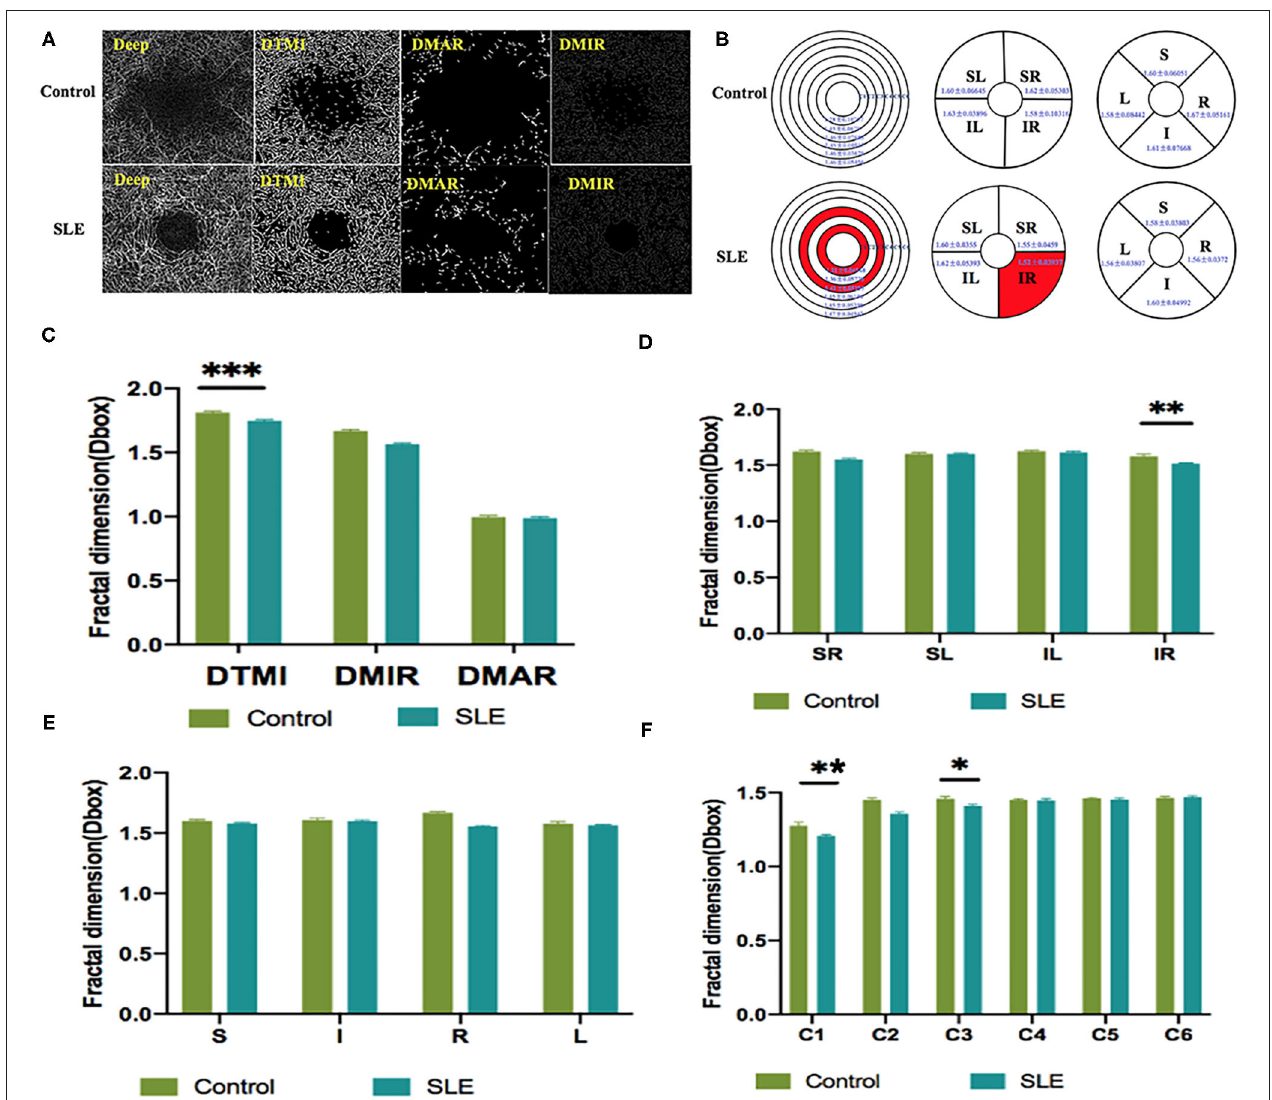
FIGURE 4 | The OCTA images and vessel density analysis of deep retinal layer of control and SLE groups. (A) Deep retinal vessel density map. (B) Results of deep retinal vascular density in different regions of normal group and SLE group (MD ± SD); (C–F) Results of deep retinal vascular density analysis in normal and SLE groups. STMI, Superficial total microvascular; SMAR, Superficial macrovascular; SMIR, superficial microvascular; SLE, Systemic lupus erythematosus; L, left; R, right; S, superior; I, inferior; IL, inferior left; IR, inferior right; SL, superior left; SR, superior right. * P < 0.05; ** P < 0.01; *** P <